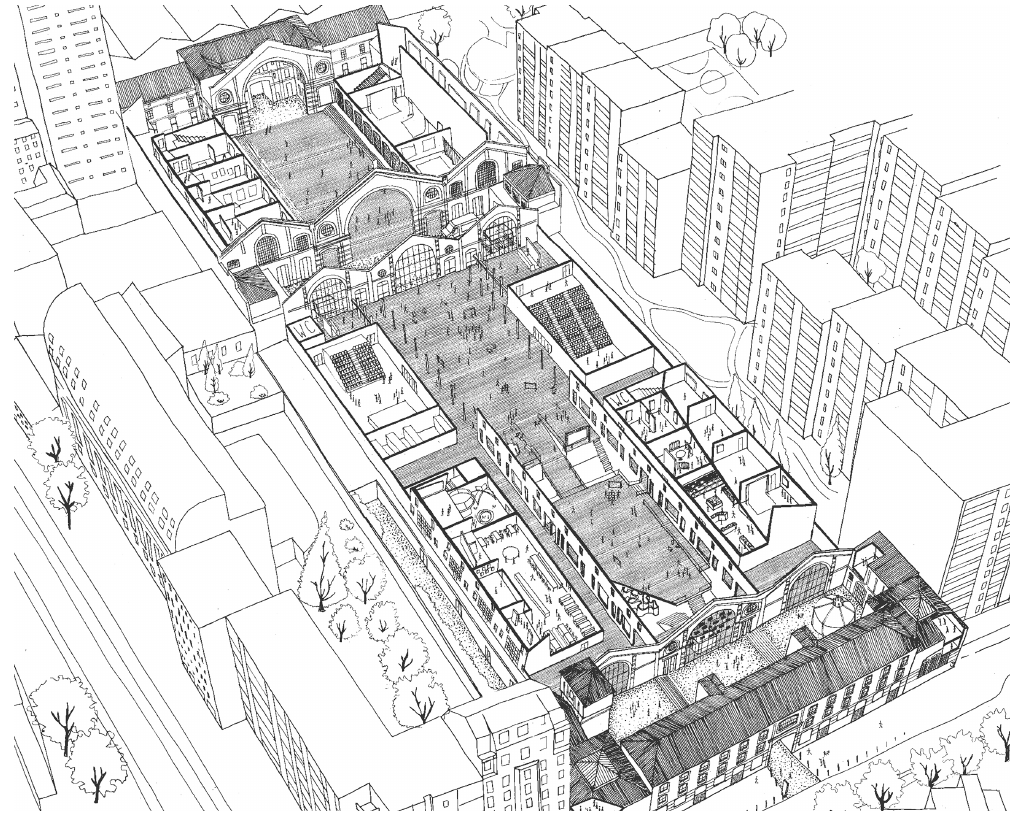
Figure 3. Complexity of the Centquatre. c (cid:13) Encore Heureux,